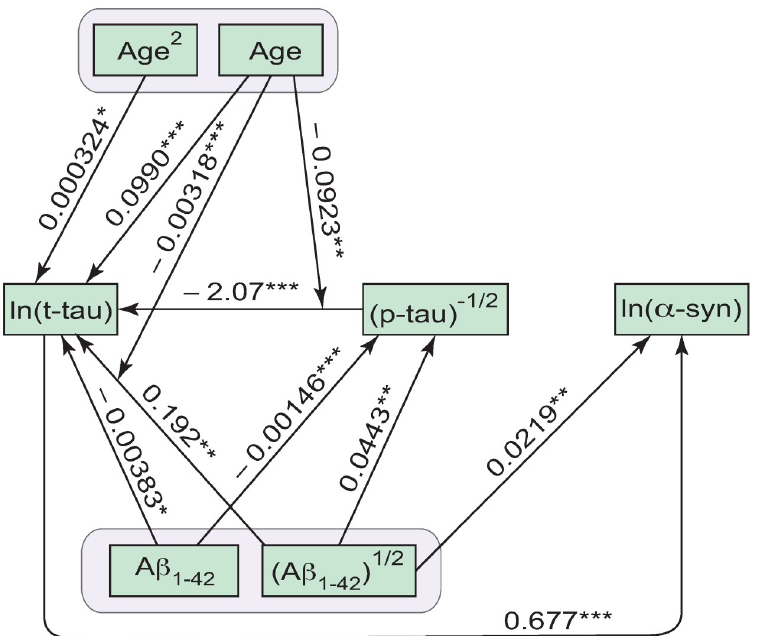
Fig 2. The alternative (to Fig 1B) network of effects between the four CSF measures and Age, with A β 1–42 as the primary independent protein variable. The arrows between the variables show the directions of the direct effects. The arrows pointing to other arrows indicate the significant interaction effects. The asterisks indicate the levels of statistical significance of the respective regression coefficients: ( ��� ) p < 0.001; ( �� ) 0.001 � p < 0.01; ( � ) 0.01 � p < 0.05.